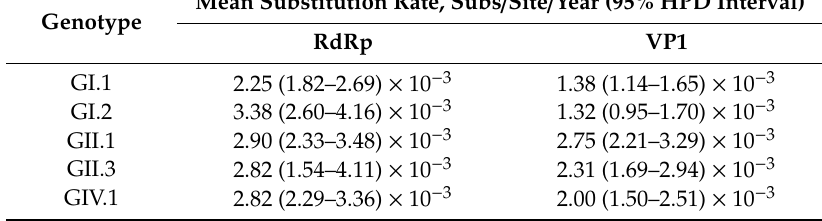
Table 4. Evolutionary rate of the RdRp- and VP1-encoding nucleotide sequences for major five genotypes of human sapoviruses.